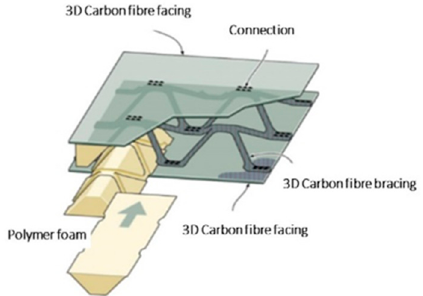
Figure 6. Hybrid composite core of a composite panel with 3D woven carbon fibre composite faces. Adapted from Adapted from [25].